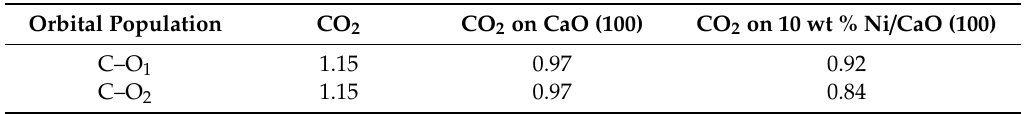
Table 2. Bond populations of CO 2.